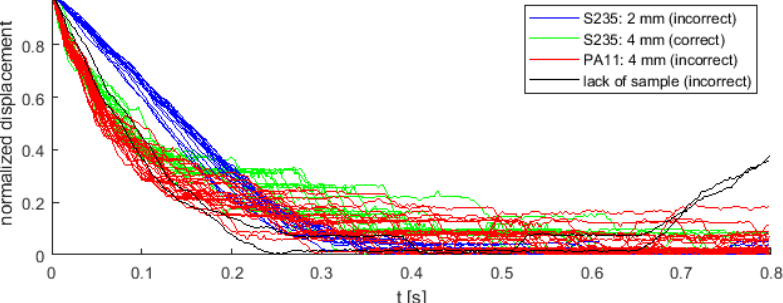
Figure 4. Sample normalized displacement signals from the extrusion process.